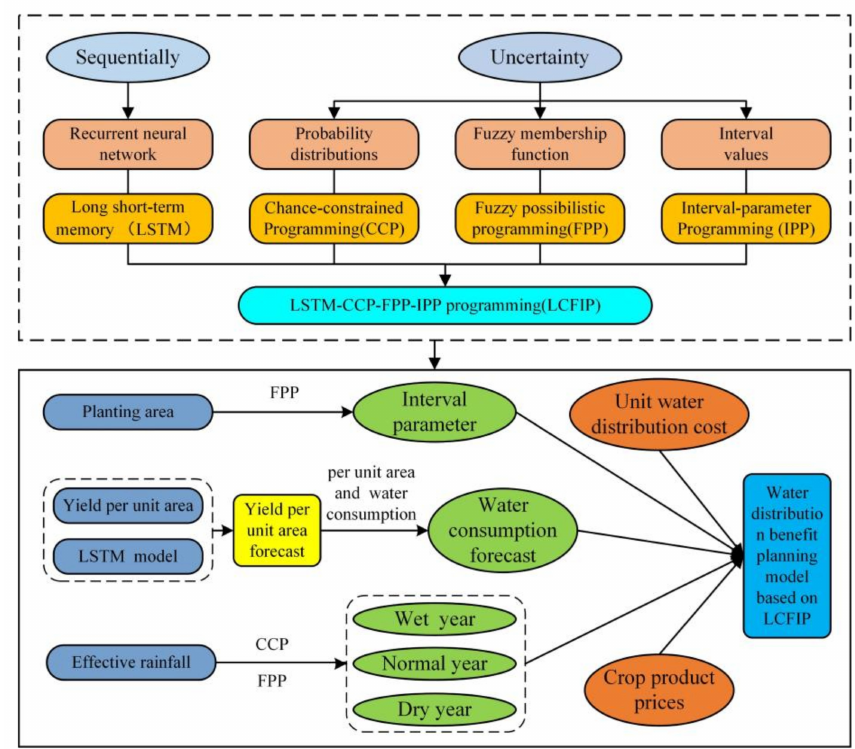
Figure 3. Schematic of the LSTM-CCP-FPP-IPP planning programming.